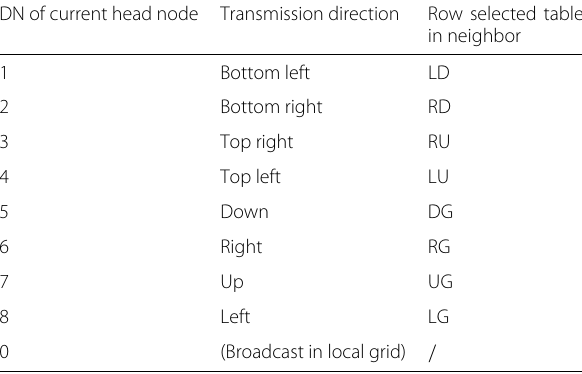
Fig. 5 The neighbor grid cells and corresponding rows in neighbor table. Node A is the head node